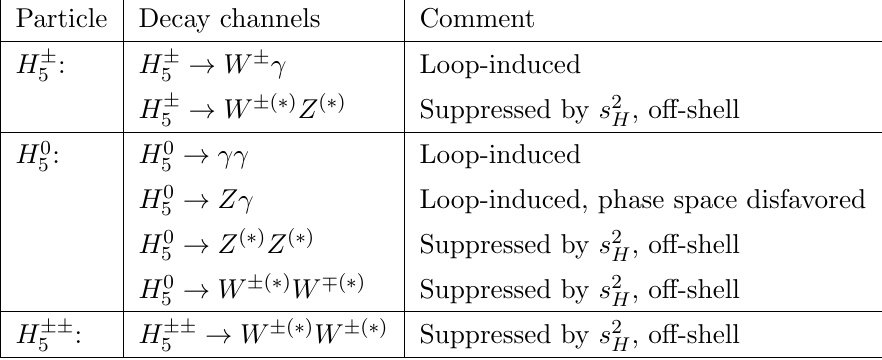
Table 2 . Decay channels for members of the scalar (cid:12)veplet at low mass, including possible o(cid:11)-shell decays. We consider the case in which the (cid:12)veplet is the lightest extra scalar; hence decays into other new scalars are kinematically